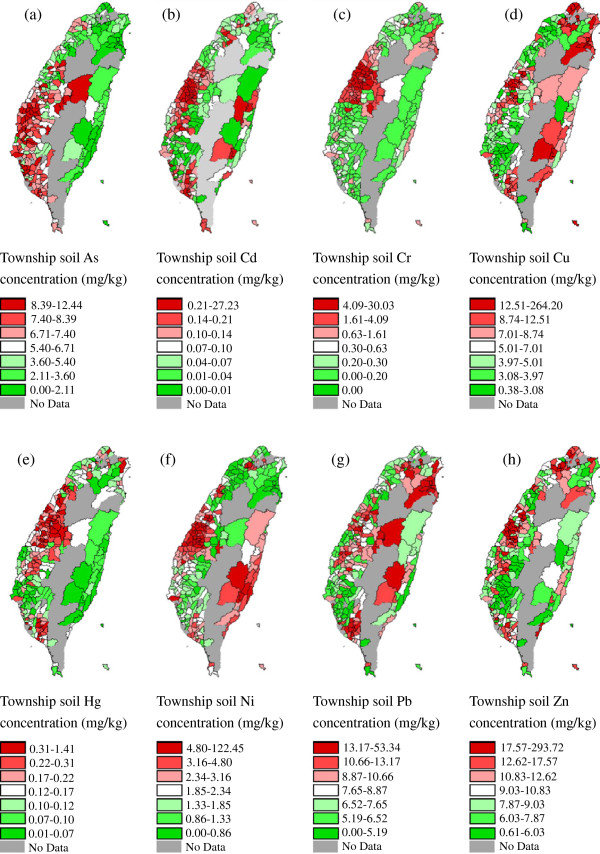
Spatial distributions of township soil heavy metal concentration (mg/kg) during 1982-1986 in Taiwan. Detailed legend: (a) As, (b) Cd, (c) Cr, (d) Cu, (e) Hg, (f) Ni, (g) Pb, (h) Zn.